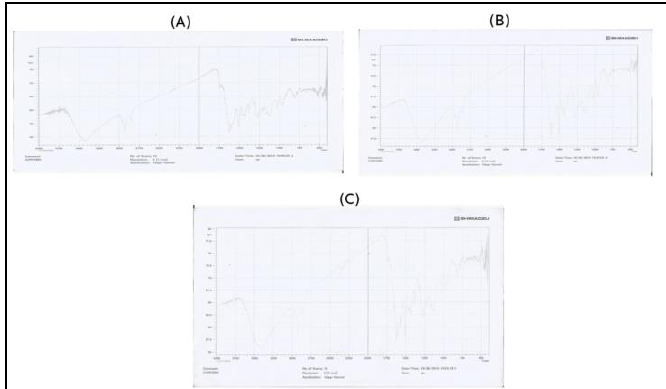
Figure 3: IR spectrum analysis results of curcumin for samples 1 (A), 2 (B) and 3 (C).